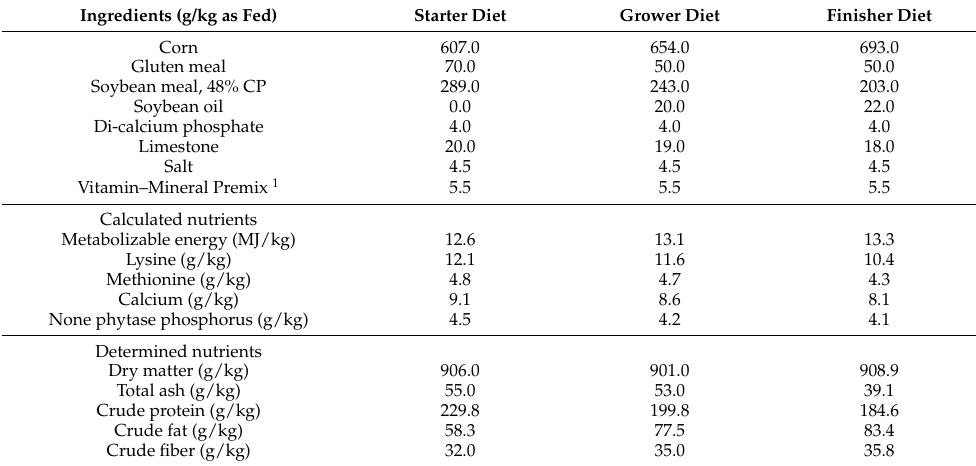
Table 2. Ingredients and nutritional composition of the starter (0–7 day), grower (8–21 day) and finisher (22–42 day) feed rations introduced to the Cobb500 broiler